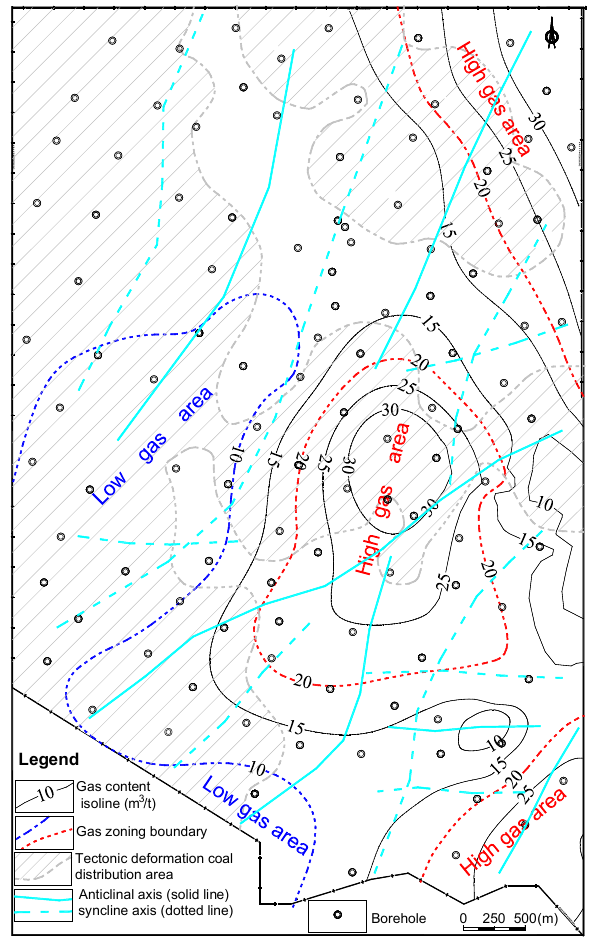
Figure 6. Gas content and distribution of tectonic deformed coal ( DV ≥ 22) of the No. 3 coal seam.